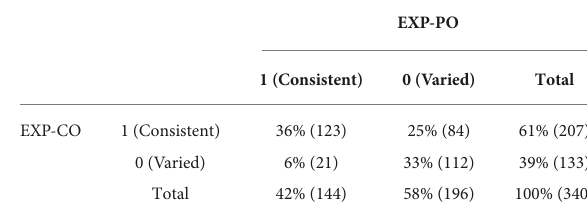
TABLE 4 Response consistency between EXP-CO and EXP-PO total